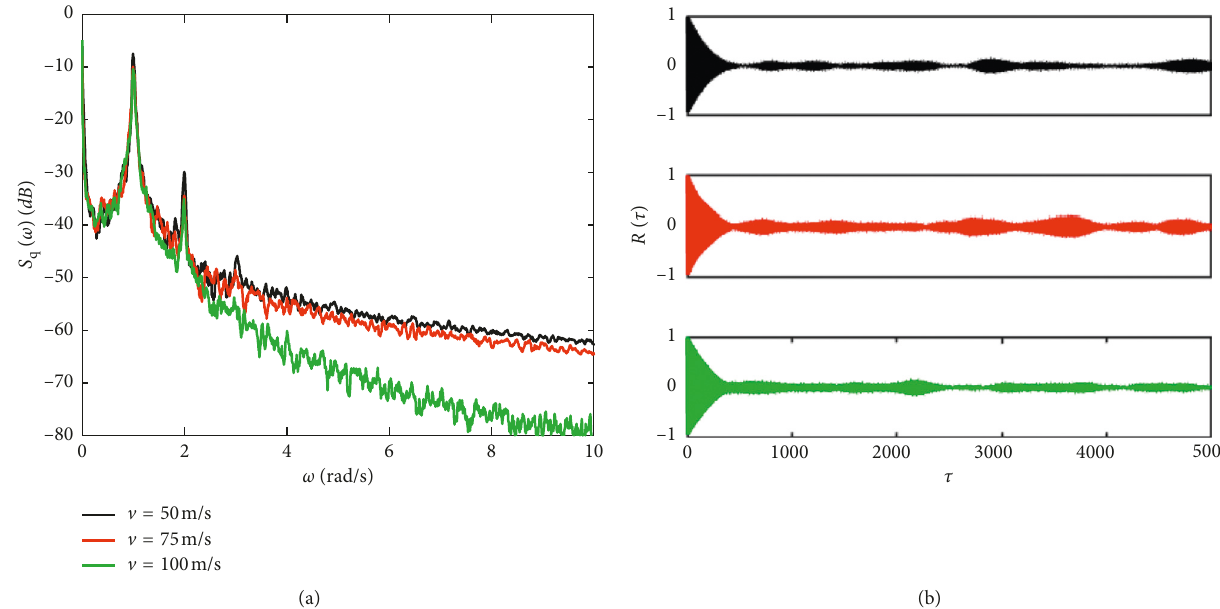
Figure 6: PSD curves and the correlation function of traverse displacement when D �